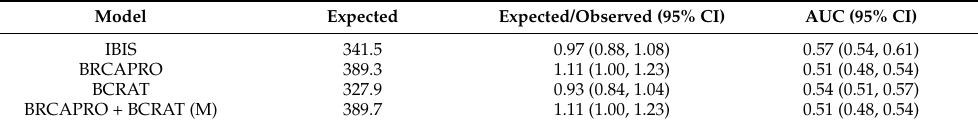
Table A9. Performance of IBIS, BRCAPRO, BCRAT, and BRCAPRO + BCRAT in original